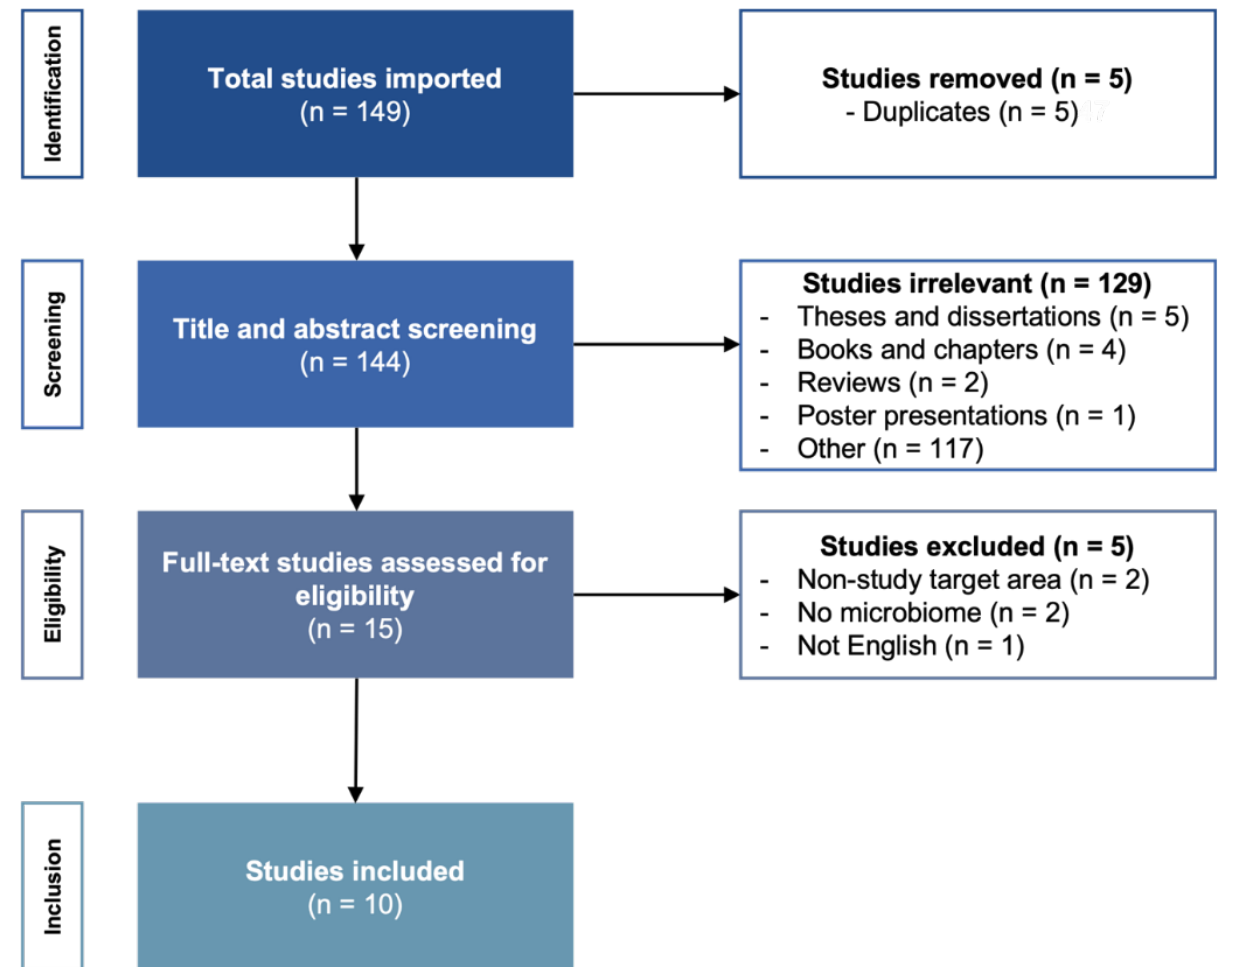
Figure 1. Flowchart of the search strategy for the selection of relevant articles following PRISMA methodology.